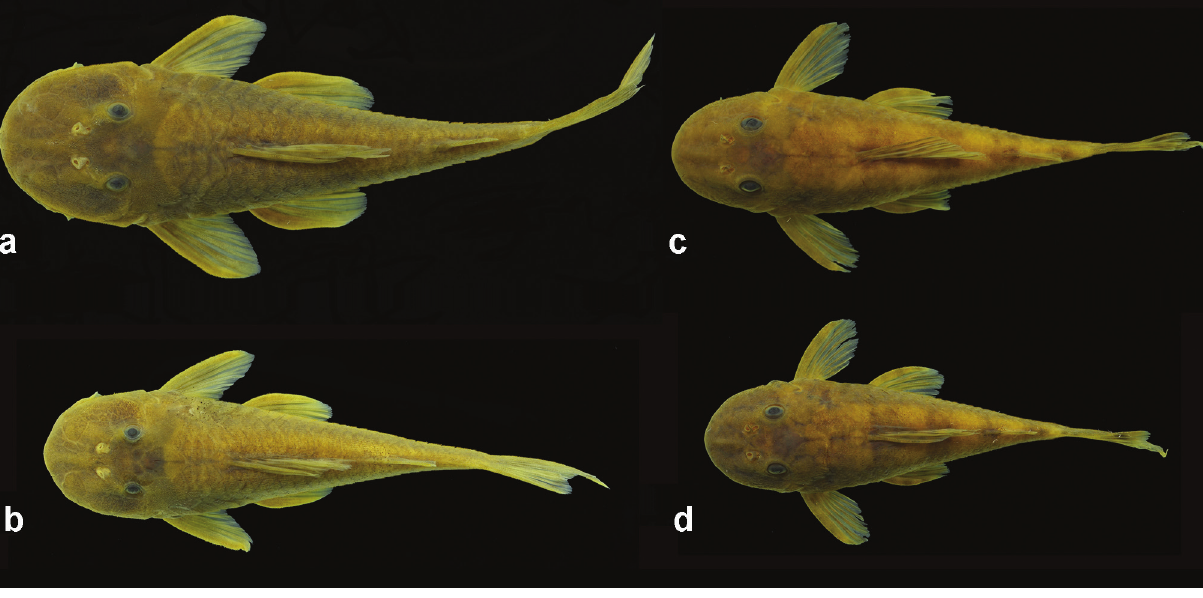
Fig. 6 . General shape and color pattern of females of Pareiorhaphis lineata , a. MCP 50876, 67.6 mm SL, and b. 56.3 mm SL; and P. stephanus , c. LIRP 4127, 47.4 mm SL, and d. 40.3 mm